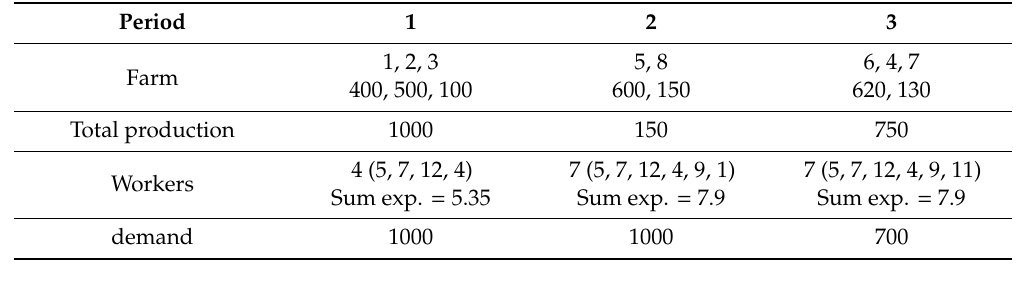
Table 4. Result of the production plan and worker assignment.